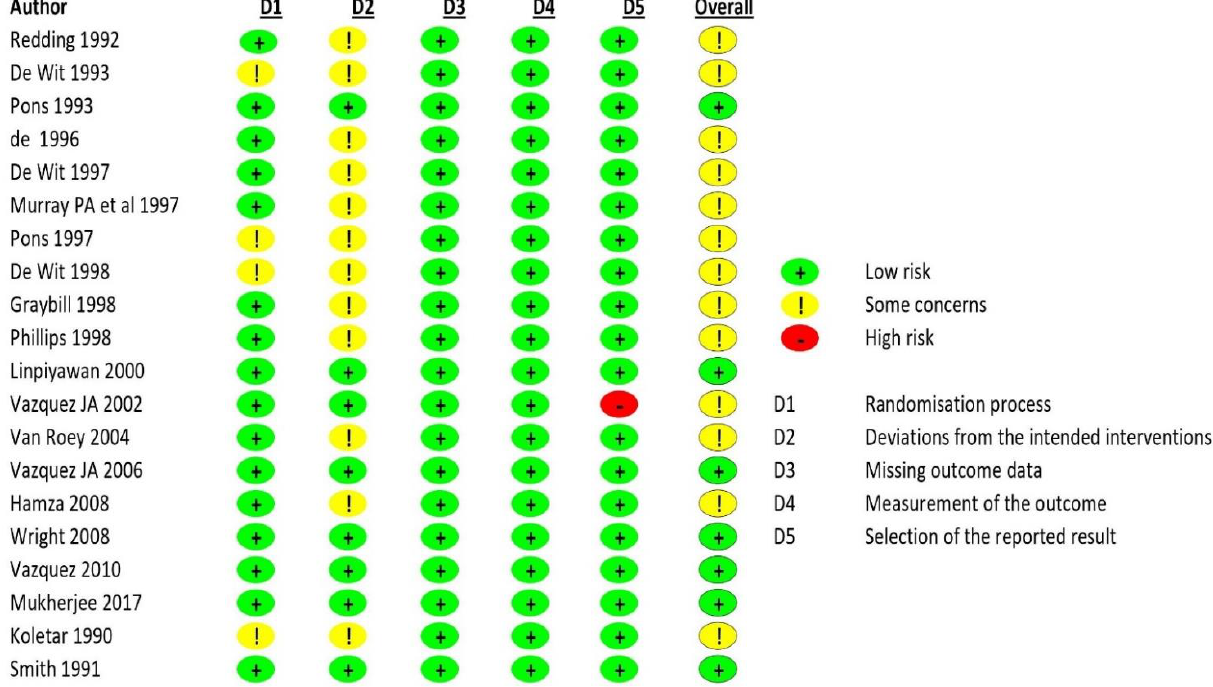
Figure 2. Risk of bias.